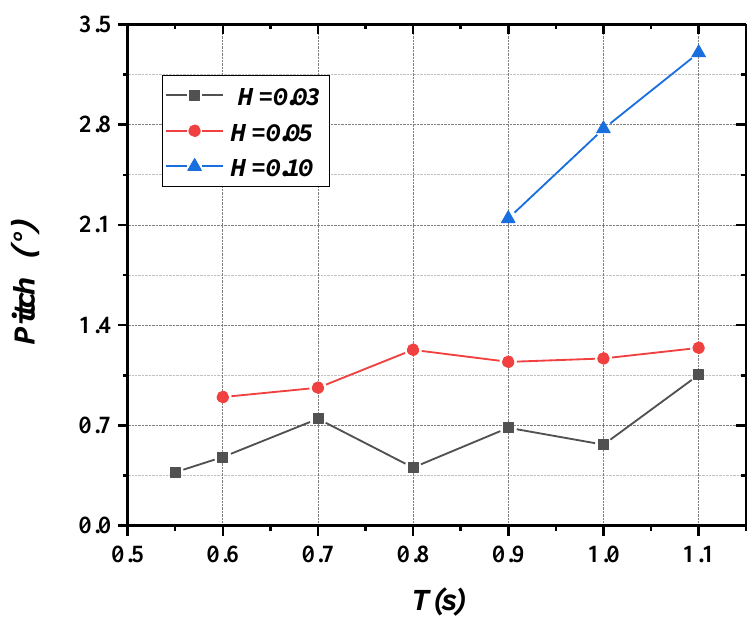
Figure 28. Variations of pitch with period and wave height.